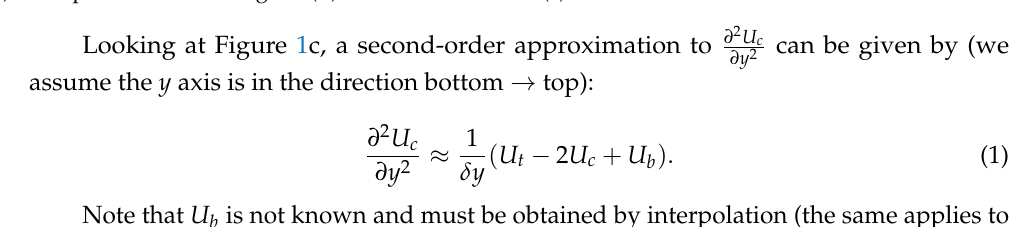
Figure 1. ( a ) Example of hierarchical grid. ( b ) Tree data structure. ( c ) Finite difference